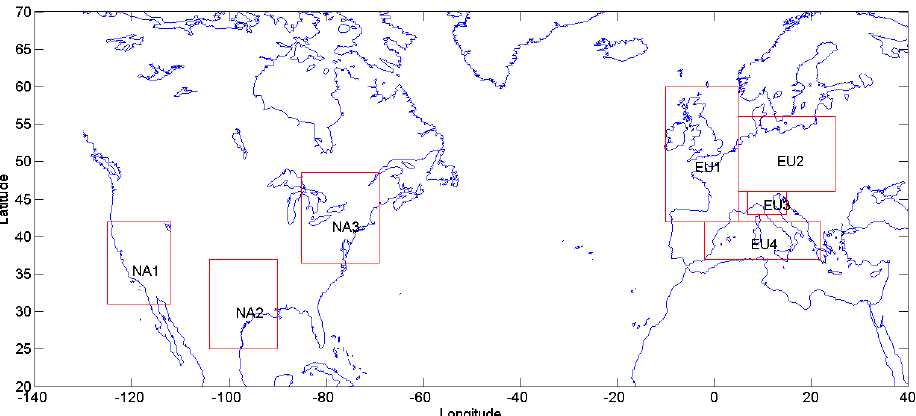
Fig. 4. Visualisation of the working